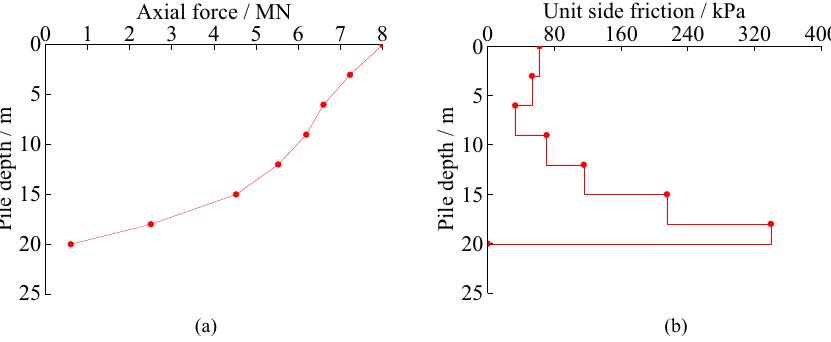
Figure 7. Load transfer law of test pile: ( a ) axial force of piles; ( b ) unit side friction of piles.